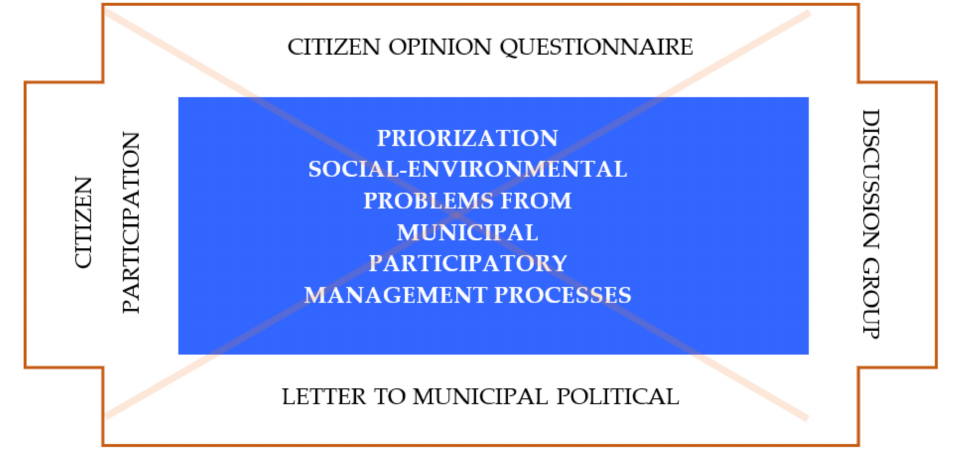
Figure 9. Triangulation process of environmental